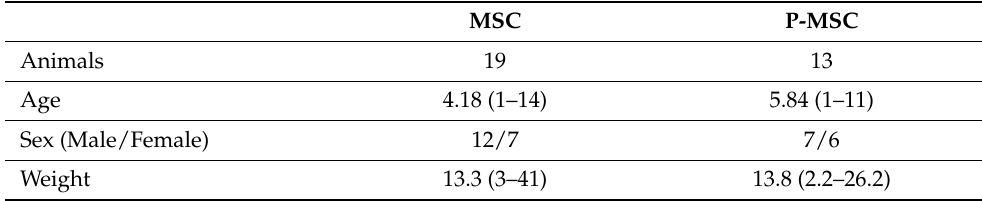
Table 1. Number of animals, average age and range (years), sex and average weight and range (kilograms) of the patients in the cell therapy (MSC) group and the combined therapy (P-MSC)